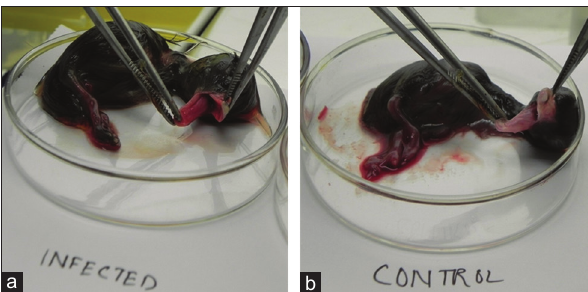
Figure-1: (a) Reddish color of infected duck embryo along with wide spread petechiae throughout the skin. (b) Control group of embryo does not showed reddish skin